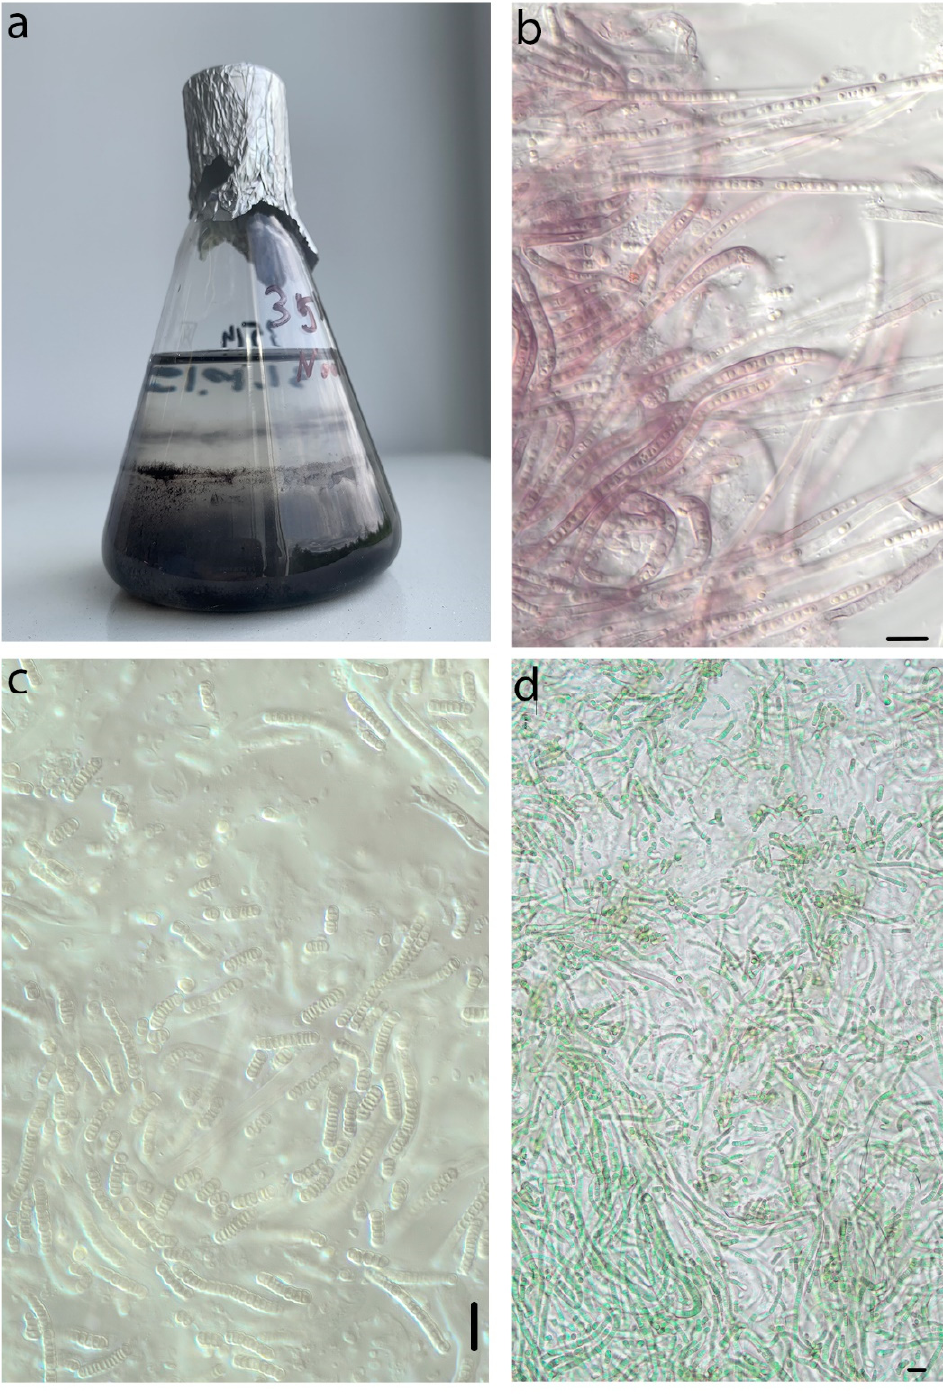
Figure 9. Morphology of cyanobacterial strains Phormidesmis nigrescens . ( a ) a liquid culture medium of KPABG 3514 strain colored by sheath production, ( b ) DIC micro-photographs of strain KPABG 3514, ( c , d ) micro-photographs of strain KPABG 3629. Scale 10 μ m. Filaments of Phormidesmis communis have thin colorless sheaths, bright, pale blue- green, or olive-green, trichomes, 1.5–3.6 μ m wide, the cells are short or, less frequently, long 1.0–4.3 μ m with constrictions at cross-walls. In cultures, the trichomes form wide and long cells (Figure 10b), the rare filaments are falsely pseudobranched. Theapical cells are rounded, and without calyptra. They are subaerophytic on wet rocks and on boulders in a slow stream (Figure 10a) or pools, forming mats on seepages.